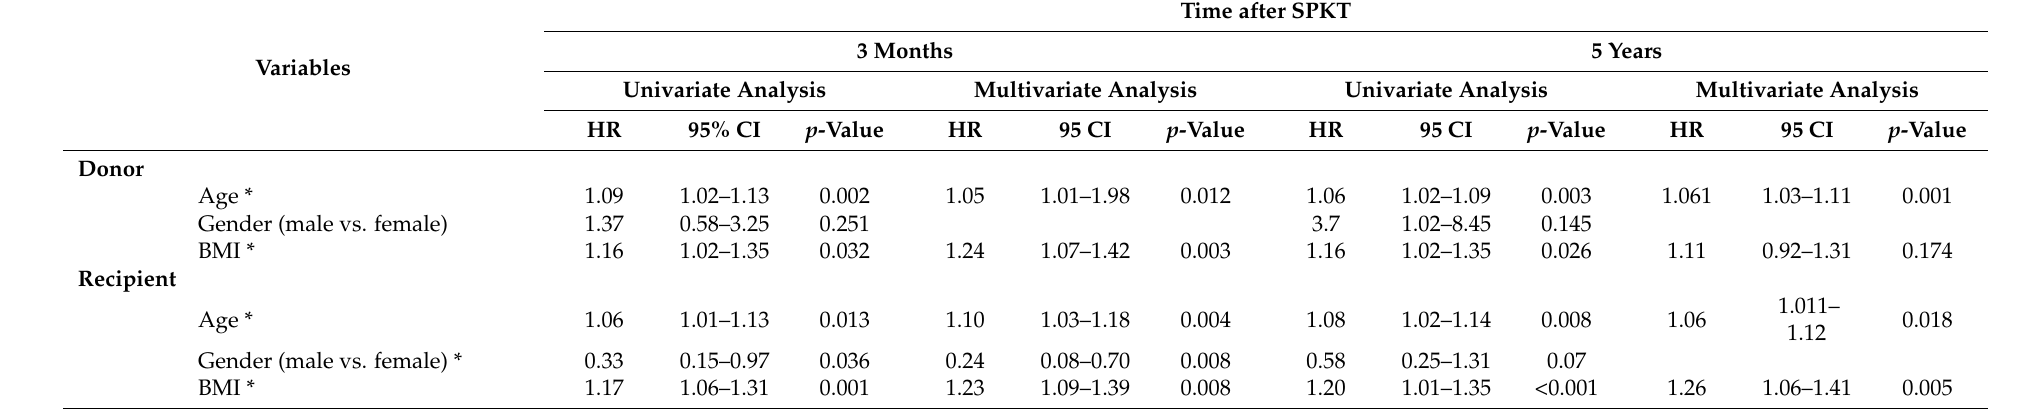
Table 5. Logistic regression analysis of predictors for pancreas allograft failure following simultaneous pancreas-kidney